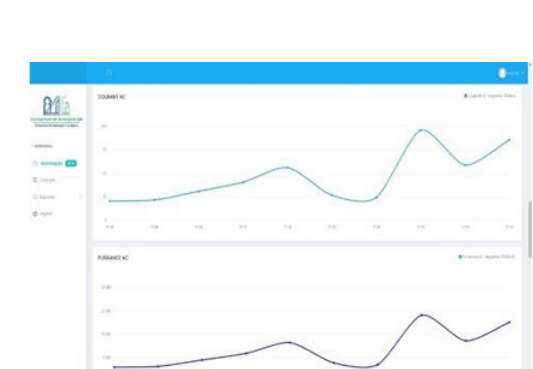
Fig. 8: AC and DC Current